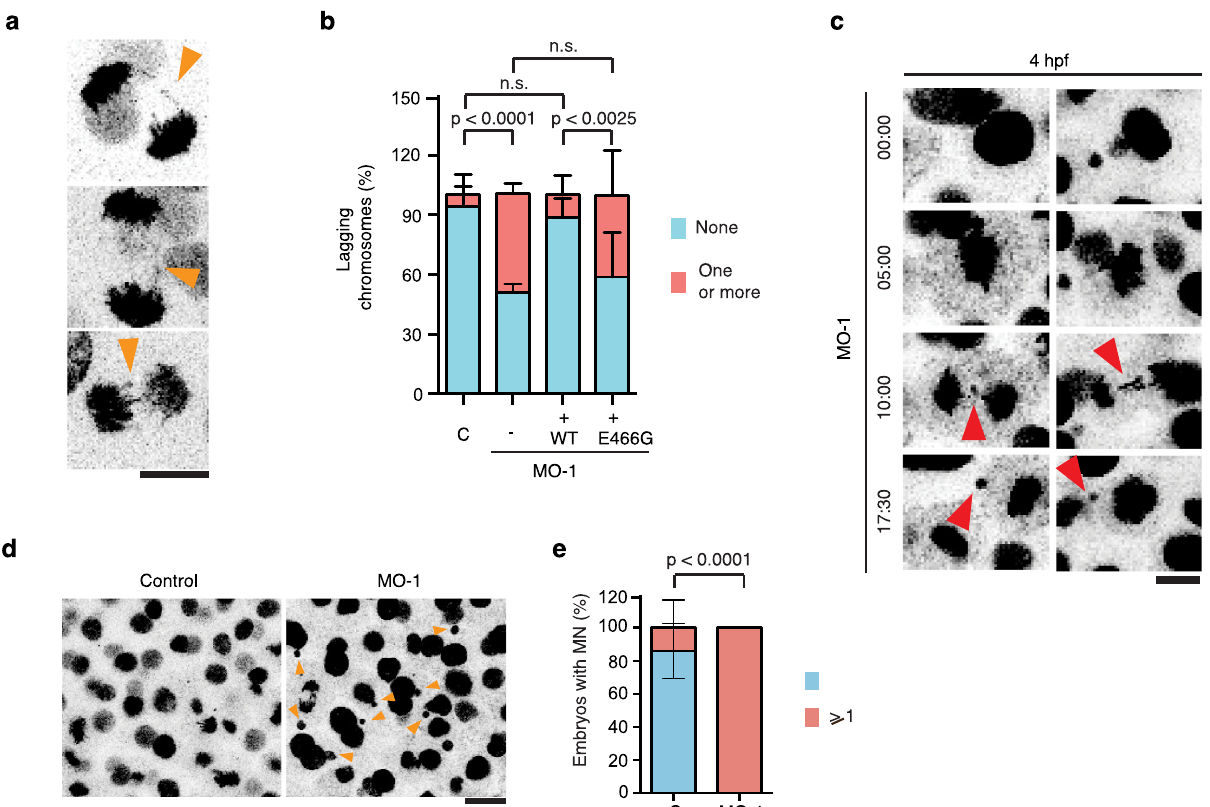
Fig. 3 | Spindle MTs polyglutamylation by TTLL11 is required for chromosome segregation fi delity in zebra fi sh embryos. a Selected images from movies of developing zfTTLL11-MO embryos showing several chromosome segregation defects in anaphase cells. Scale bar, 10 µ m. b Quanti fi cation of anaphase cells with lagging chromosomes in control and morphant embryos expressing zfTTLL11 (+WT) or the catalytically dead zfTTLL11 (+E466G). n (control)=41 embryos, n (morphant)=46embryos, n (+WT)=39embryosand n (+E466G)=31embryos.The total n is calculated over N =3 independent experiments. P values based on a two- tailed χ 2 test with a 95% con fi dence interval. Error bars represent SD. c Still images from movies of control and zfTTLL11-MO embryos expressing H2B-mCherry and